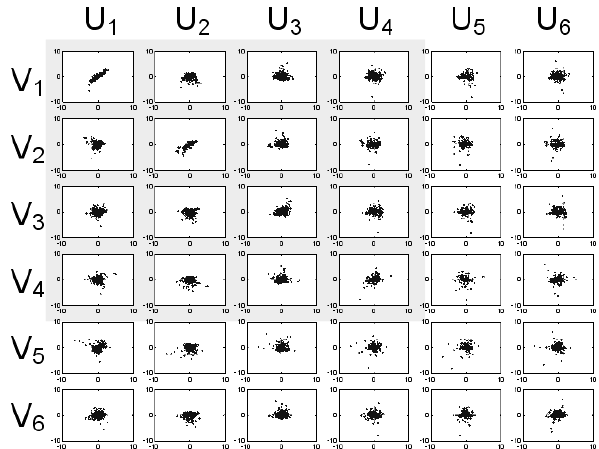
Fig. 3. Canonical variables U and V computed for the study area: scatter-plots between canonical variables U i and V j , for i and j equal to 1,2,...6.